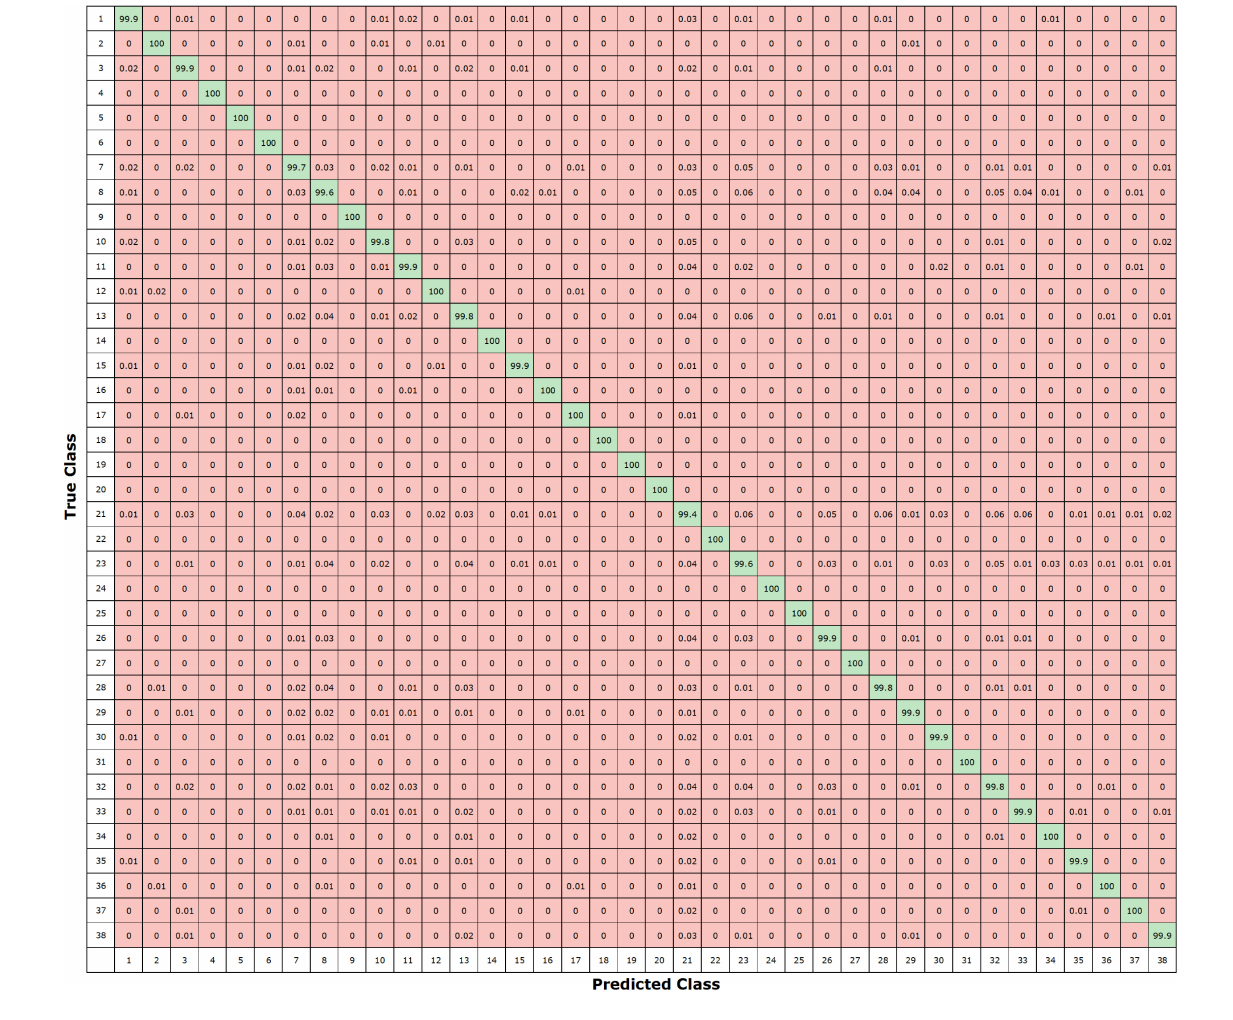
FIGURE 9 | Confusion matrix of the presented method.